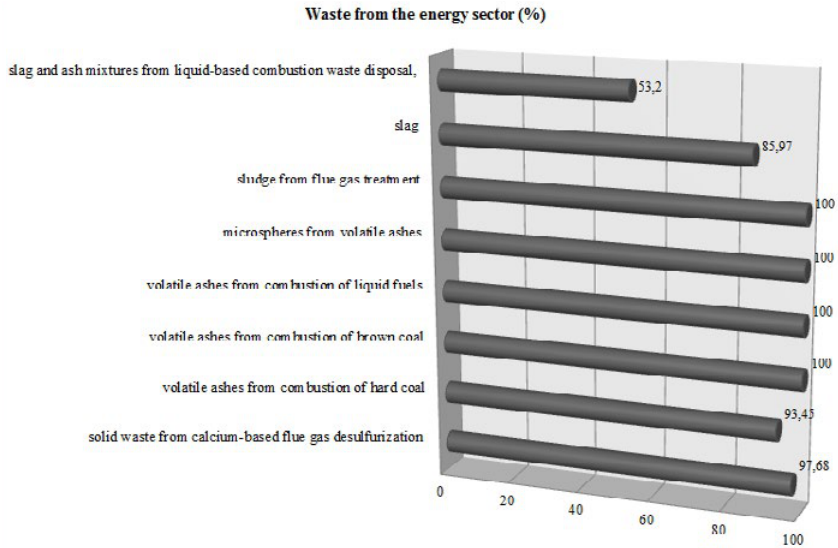
Fig. 1: The level of waste from the power industry subjected to recycling source